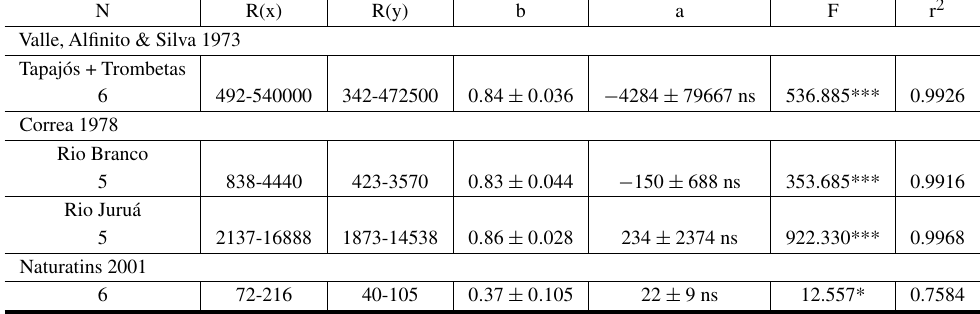
Podocnemis expansa , regression of the number of live young on the number of eggs